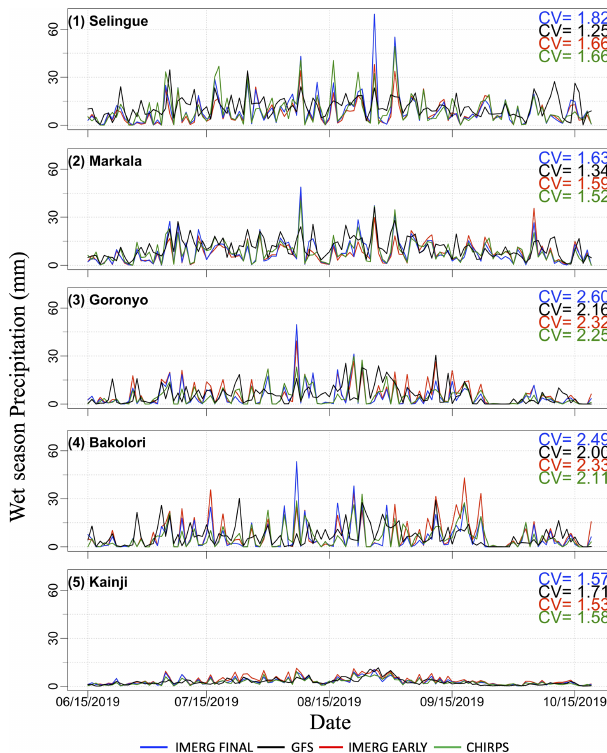
Figure 5. Time series of subbasin-averaged precipitation total (mil- limeters) for the wet period (June–September 2019) for all sub- basins and derived from various precipitation products for five sub- basins. The figure also shows the coefficient of variation (CV) as a measure of the temporal variation.